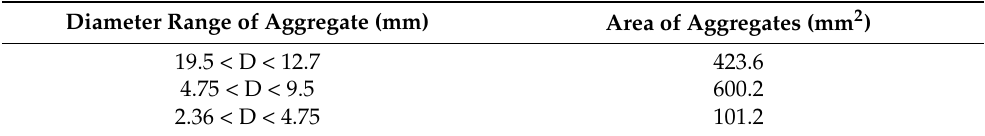
Table 1. Size distribution of